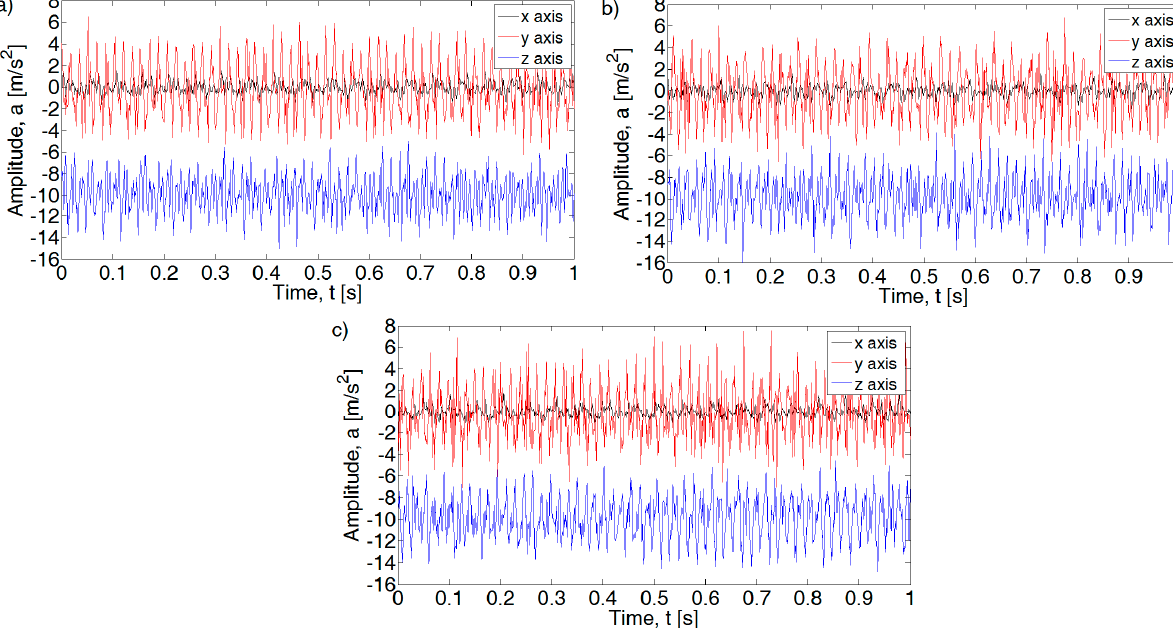
Figure 5. Exampleofaccelerationsensorsignalfor3500rpm: ( a )efficientengine, ( b )pressureinefficient, and( c Figure 5. Example of acceleration sensor signal for 3500 rpm: ( a ) efficient engine, ( b ) pressure inefficient, and ( c ) injection inefficient .